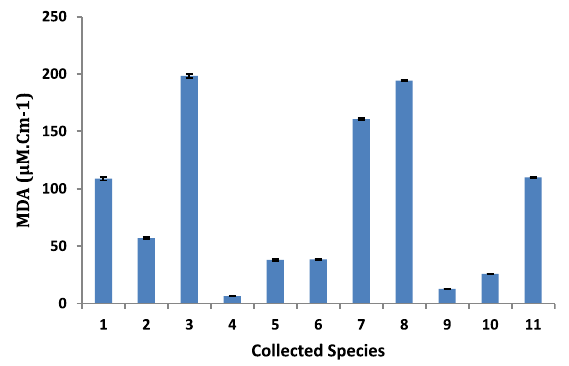
Fig. 1 Level of MDA formation in the collected